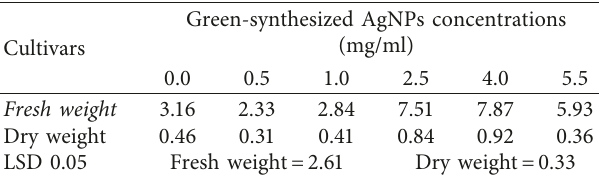
Table 5: Effect of green-synthesized AgNPs on plant fresh and dry weights (mg), n � 7.